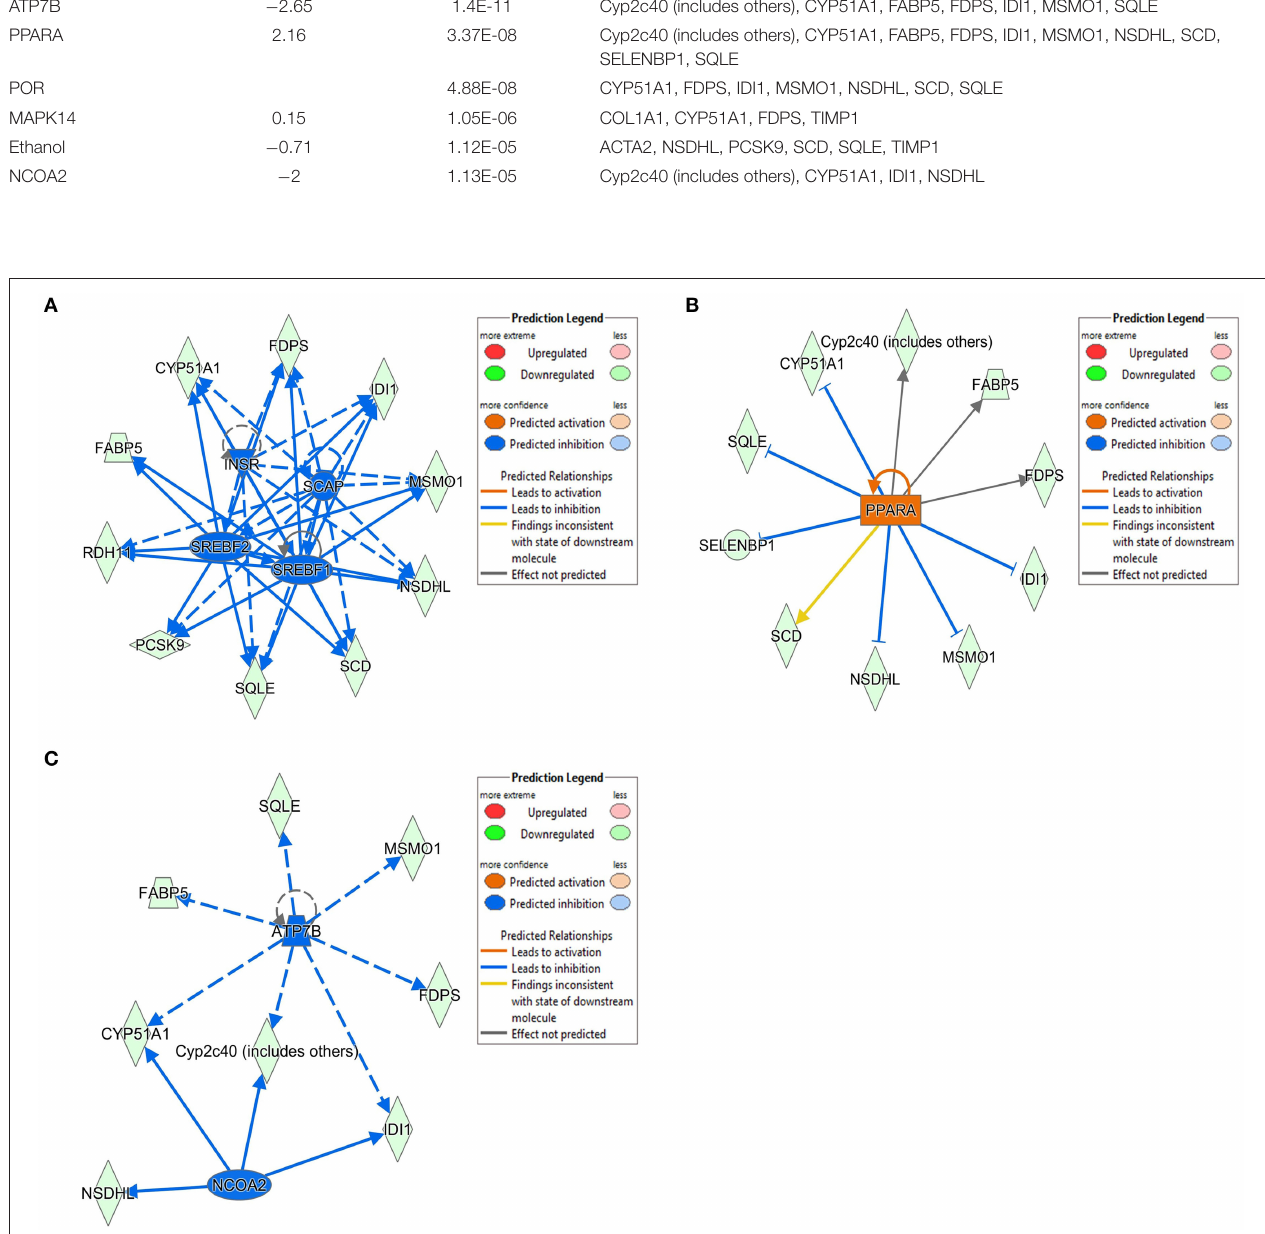
Frontiers in Physiology |